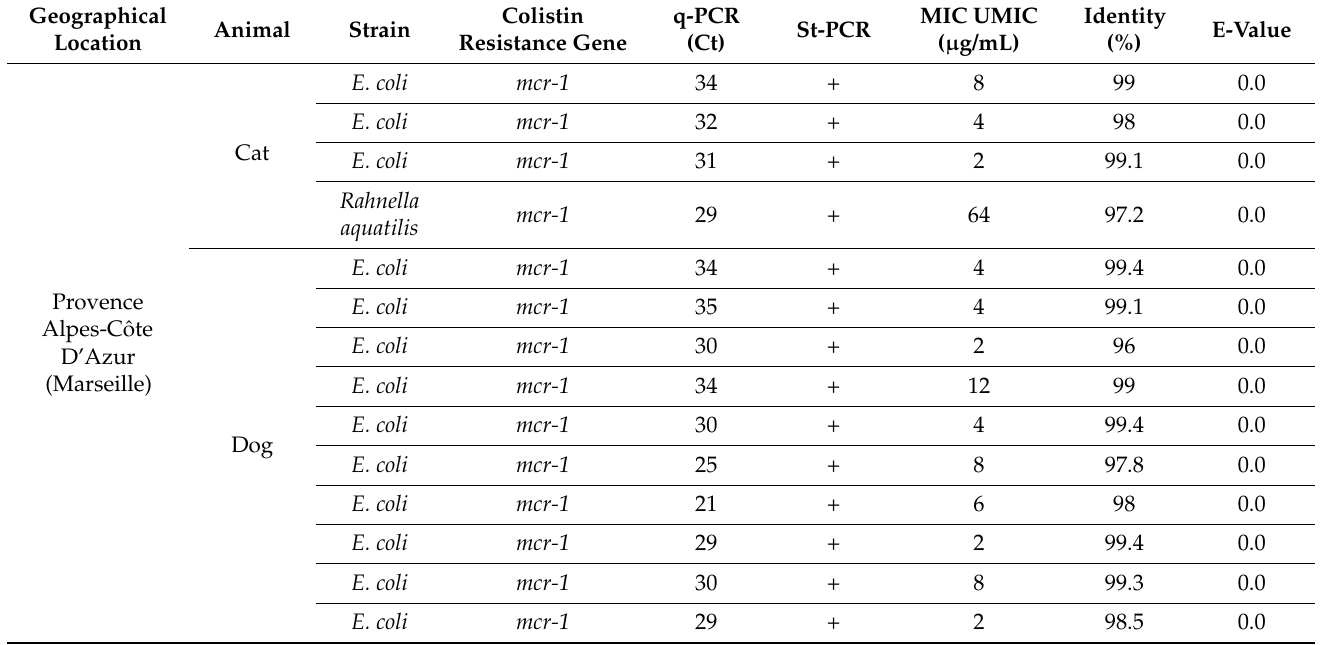
Table 1. Biomolecular results and colistin MIC of resistant bacteria harboring mcr genes isolated from dogs and